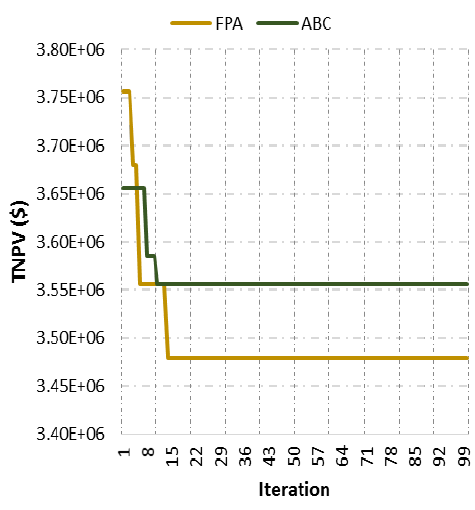
Fig. 5: Comparison of convergence rates for the FPA and the ABC techniques at